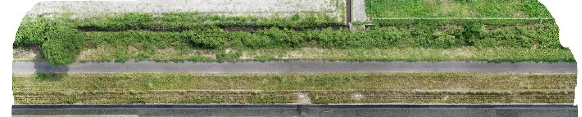
Figure 6. Orthoimage of Dataset M produced by Pix4Dmapper